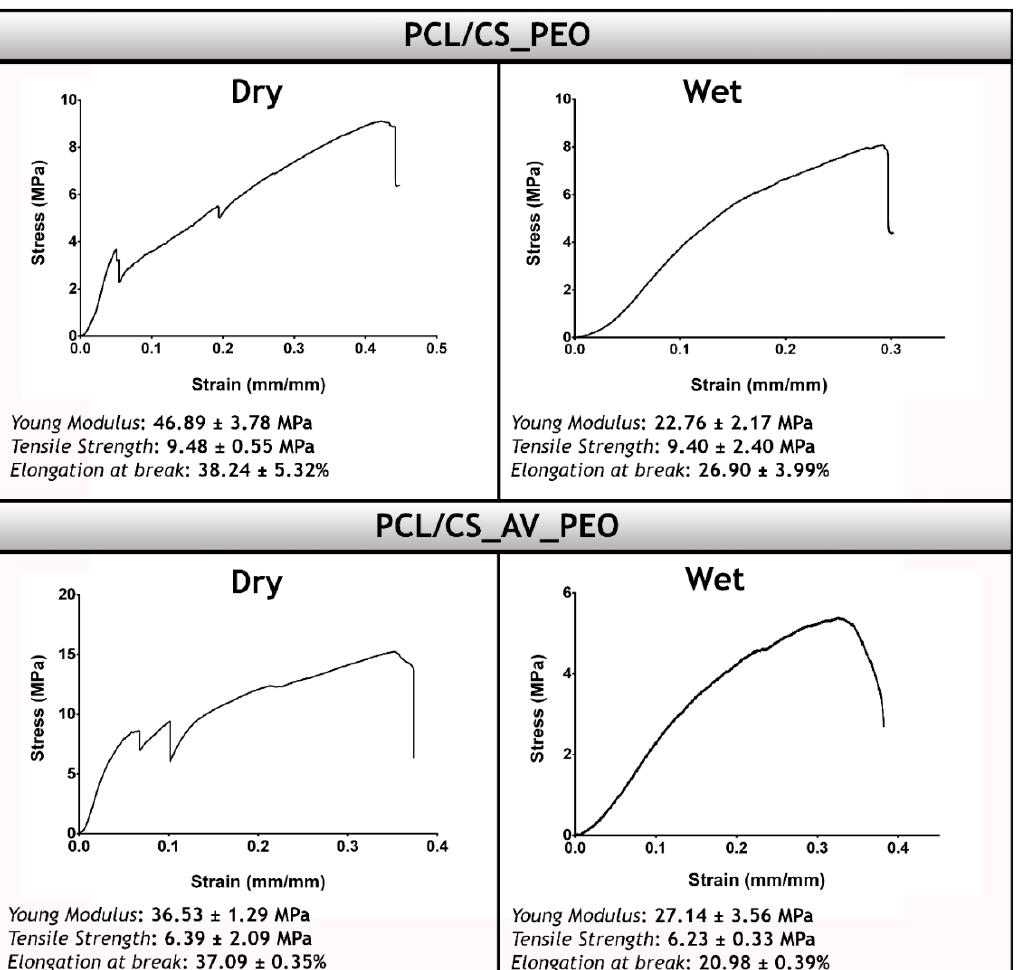
Figure 4. Typical stress-strain curves and mechanical properties determined for the produced membranes in dry and wet conditions. Young´s modulus, tensile strength, and elongation at break of PCL/CS_PEO and PCL/CS_AV_PEO membranes. PCL/CS_PEO membranes presented a Young Modulus of 46.89 ± 3.78 MPa in dry state,